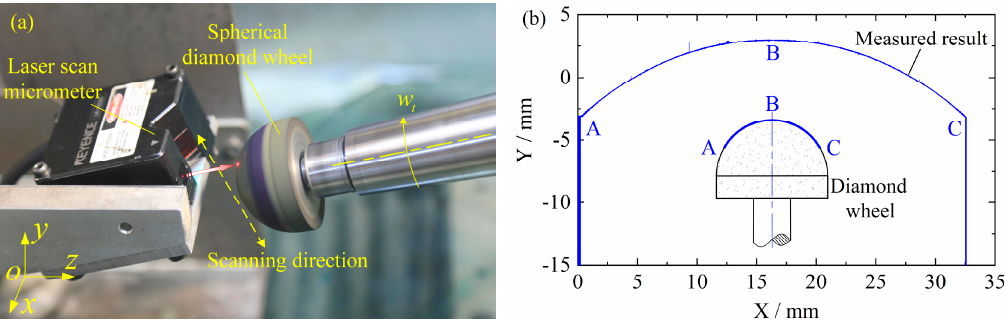
Figure 5. In-situ measurement of spherical diamond wheel profile: ( a ) measurement, ( b ) results.